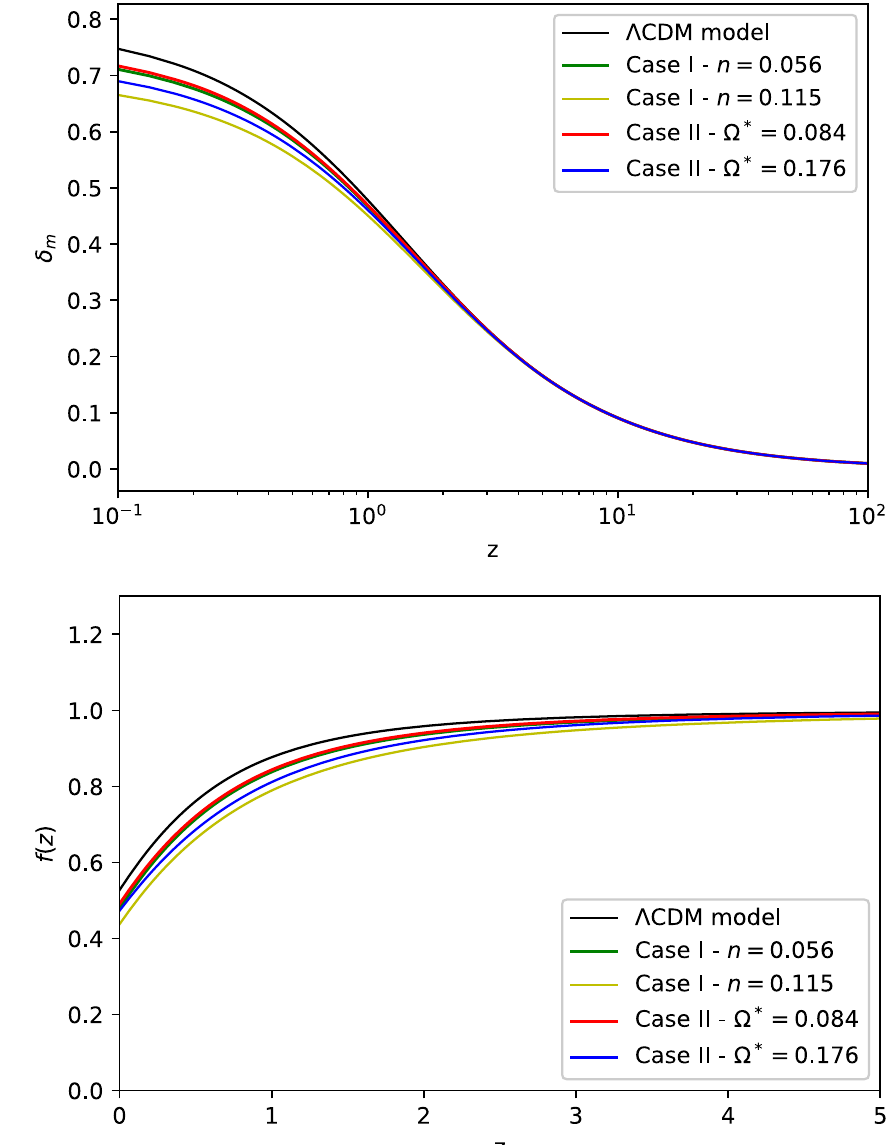
Fig. 5 Top panel: Growth of the density contrast δ m of matter for both cases. The curves were plotted with the values of the parameters in Tables 1 and 2, with different values of n and (cid:7) ∗ . The evolution of matter density contrast for (cid:2) CDM model is also presented for comparison (upper black line). Bottom panel: Growth function f of matter for the fermionic model and for (cid:2) CDM model (black line) for